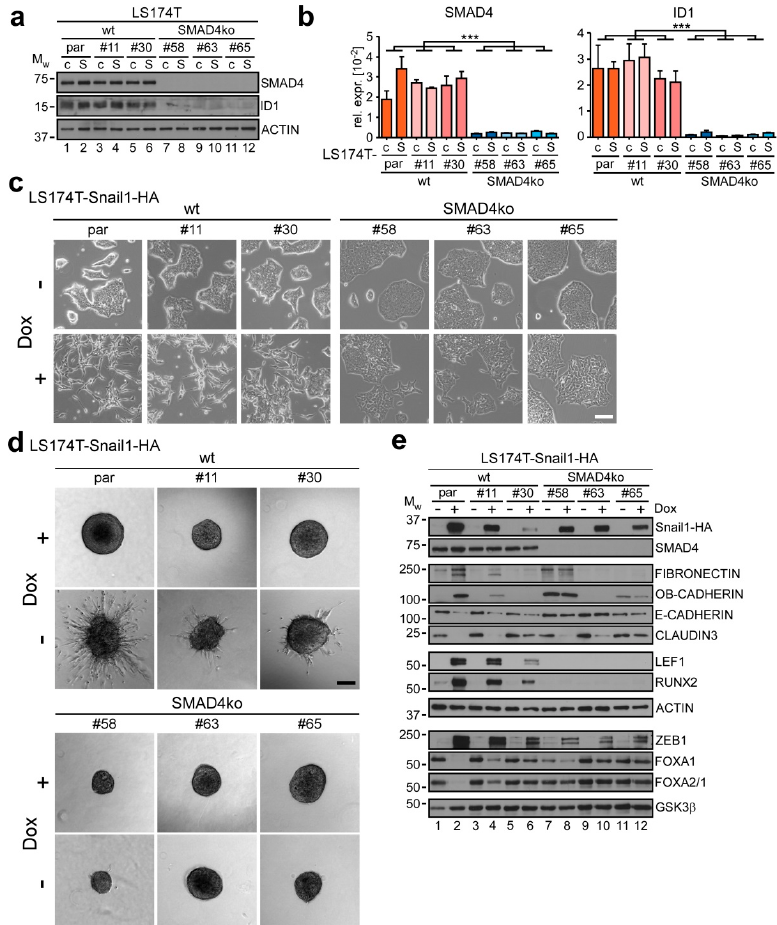
Figure 4. SMAD4 is required for SNAIL1-induced EMT in colorectal cancer cells. ( a ) Western blot analyses of whole-cell lysates. Names of detected proteins are indicated on the right. Positions of molecular weight (M W ) standards in kDa are given on the left. Detection of ACTIN was used as control for equal loading. par: parental, c: control, S: Snail1-HA. ( b ) qRT-PCR analyses of mRNA expression in LS174T parental (par) cells and single cell clones reconstituted with inducible control ( c ) or Snail1-HA (S) expression vectors. Statistical significance was analyzed by first testing for di ff erences among the three wt (par, #11, #30) and the three SMAD4 ko (#58, #63, #65) clones by one-way ANOVA. As there were no significant intra-group di ff erences for both genes, values for each clone were averaged and inter-group di ff erences between wt and SMAD4 ko were determined using unpaired two-tailed student’s t -test. Shown is the mean + SEM; n = 3. Rel. expr.: relative expression normalized to that of GAPDH . ***: p < 0.001. ( c ) Morphology of LS174T parental (par) cells and single cell clones reconstituted with inducible Snail1-HA expression vector. Cells were left uninduced or received 0.1 µ g · mL − 1 Dox for 72 h. Scale bar: 100 µ m. ( d ) Spheroid invasion assay of LS174T parental (par) cells and single cell clones reconstituted with an inducible expression vector for Snail1-HA. Cells were left untreated or received 0.1 µ g · mL − 1 Dox for 72 h. One representative spheroid is shown per condition. Scale bar: 200 µ m. ( e ) Western blot analyses of proteins indicated on the right. Cells were left untreated or received 0.1 µ g · mL − 1 Dox for 72 h. Positions of molecular weight (M W ) standards in kDa are given on the left. Detection of ACTIN and GSK3 β was used as control for equal loading. Proteins were detected using whole-cell lysates, except for FOXA1, FOXA2, ZEB1 and GSK3 β for which nuclear extracts were used. As not all proteins could be analyzed on the same membrane, only one representative loading control is shown for the di ff erent extraction methods for reasons of simplicity. All corresponding loading controls for the images depicted can be found in Figure